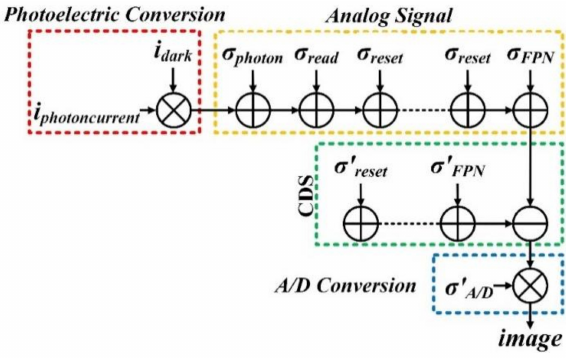
Figure 6. Charge transfer process and noise sources of image